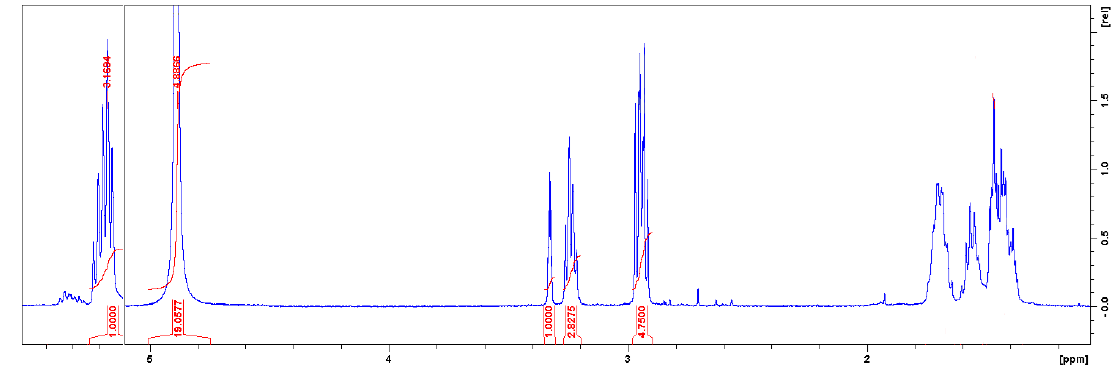
Figure 4. NMR spectrum of PHU-based polymer (dissolved in CD 3 OD).